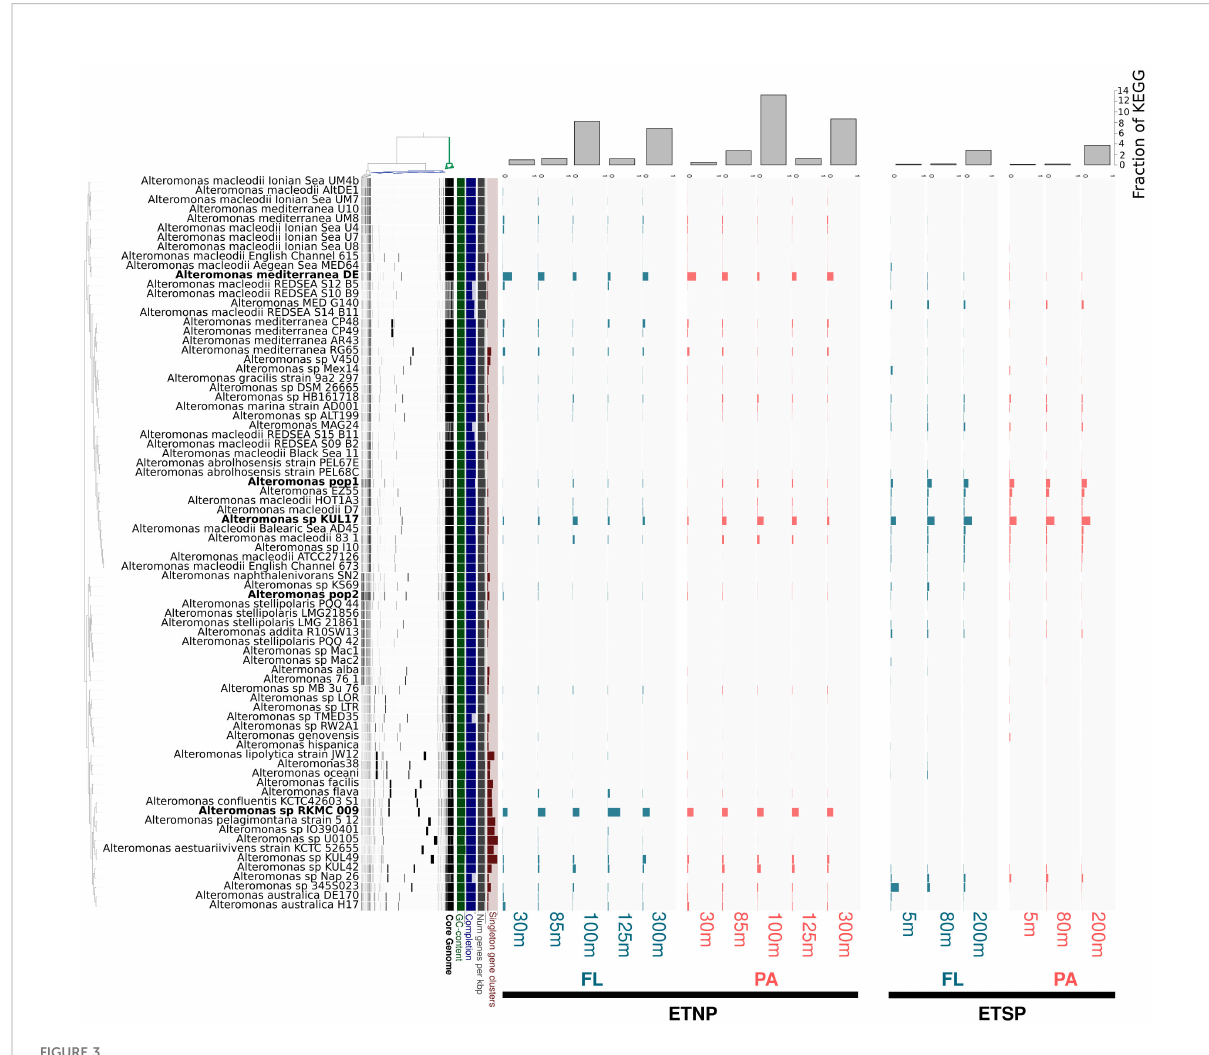
FIGURE 3 Pangenomic analysis of the Alteromonas genomes and percentage recruitment of OMZ metatranscriptome read fragments. Pangenomic analysis of the Alteromonas genomes and fragment recruitment of OMZ metatranscriptomes. A. The dendrogram at the left shows the clustering of 76 isolated genomes and the two SAGs populations based on the distribution of 7,385 genes (black bars) recovered from the pangenomic analysis (Euclidean distance and ward D2 clustering). The barplots corresponds to metatranscriptome reads recruited to each genome represented as a fraction of the total Alteromonas recruited reads in the metatranscriptome. ETNP, Eastern Tropical North Paci fi c; ETSP, Eastern Tropical South Paci fi c; FL, Free-Living; PA, Particle-Attached. The upper barplot corresponds to the relative recruit over all the Alteromonas genomes, calculated based on the number of KOs detected in the Metatranscriptome that are present in the Alteromonas genomes and normalized to the total number of KO predicted in each Metatranscriptome (fraction of